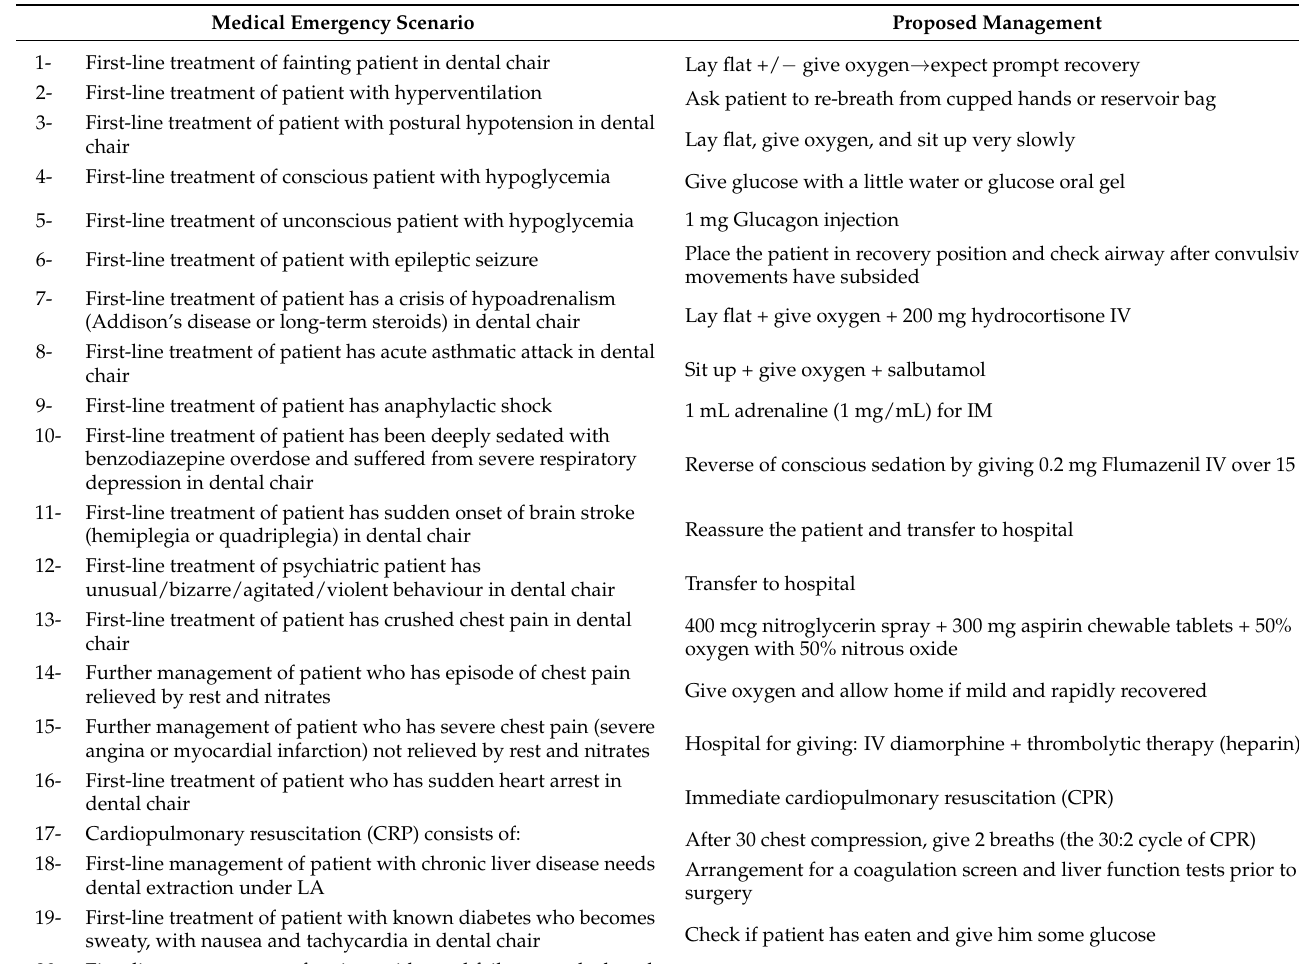
Table 1. Twenty medical emergency cases that frequently take place in the dental